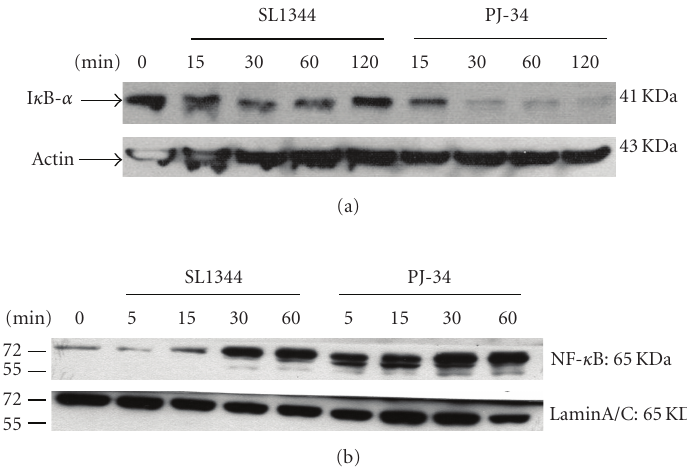
Figure 2: E ff ect of PJ-34 on Salmonella-induced activation of NF- κ B . NF- κ B is a central regulator of the intestinal epithelial cell innate immune response induced by infection with enteroinvasive bacteria. The Western blots illustrate (a) the expression of I κ -B α proteins in cytosolic extracts of Caco-2 cells exposed to wild-type S . Typhimurium strain SL1344 in the absence or presence of PJ-34. Actin works as a normalization of nuclear protein and (b) the expression of p65 NF-kB proteins in nuclear extracts of Caco-2 cells exposed to wild-type S . Typhimurium strain SL1344 in the absence or presence of PJ-34. Actin and LaminA/C work as a normalization of cytosolic and nuclear protein, respectively. The results shown are representative of 3 separate